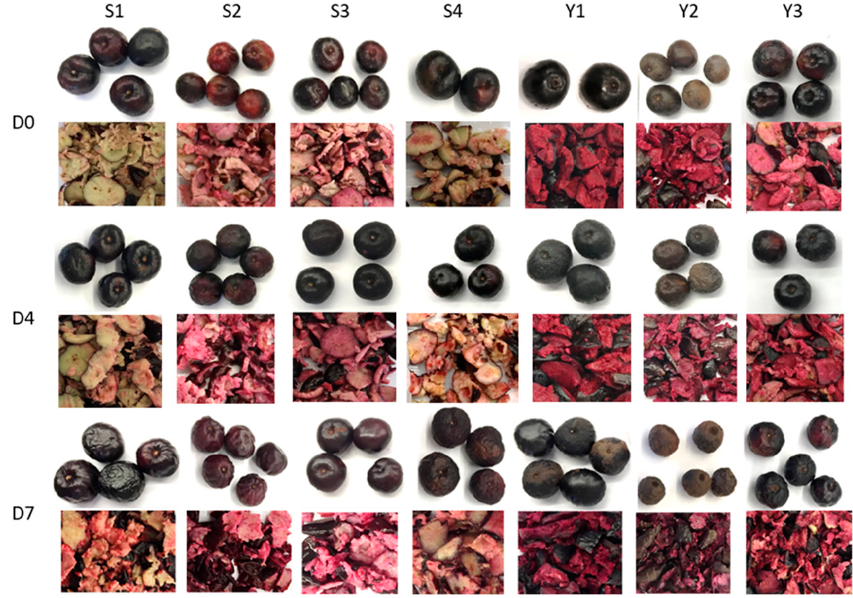
Figure 1. Whole fruits and flesh of the studied BP from seven trees (S1, S2, S3, S4, Y1, Y2, Y3) at three storage days (D0, D4, D7).